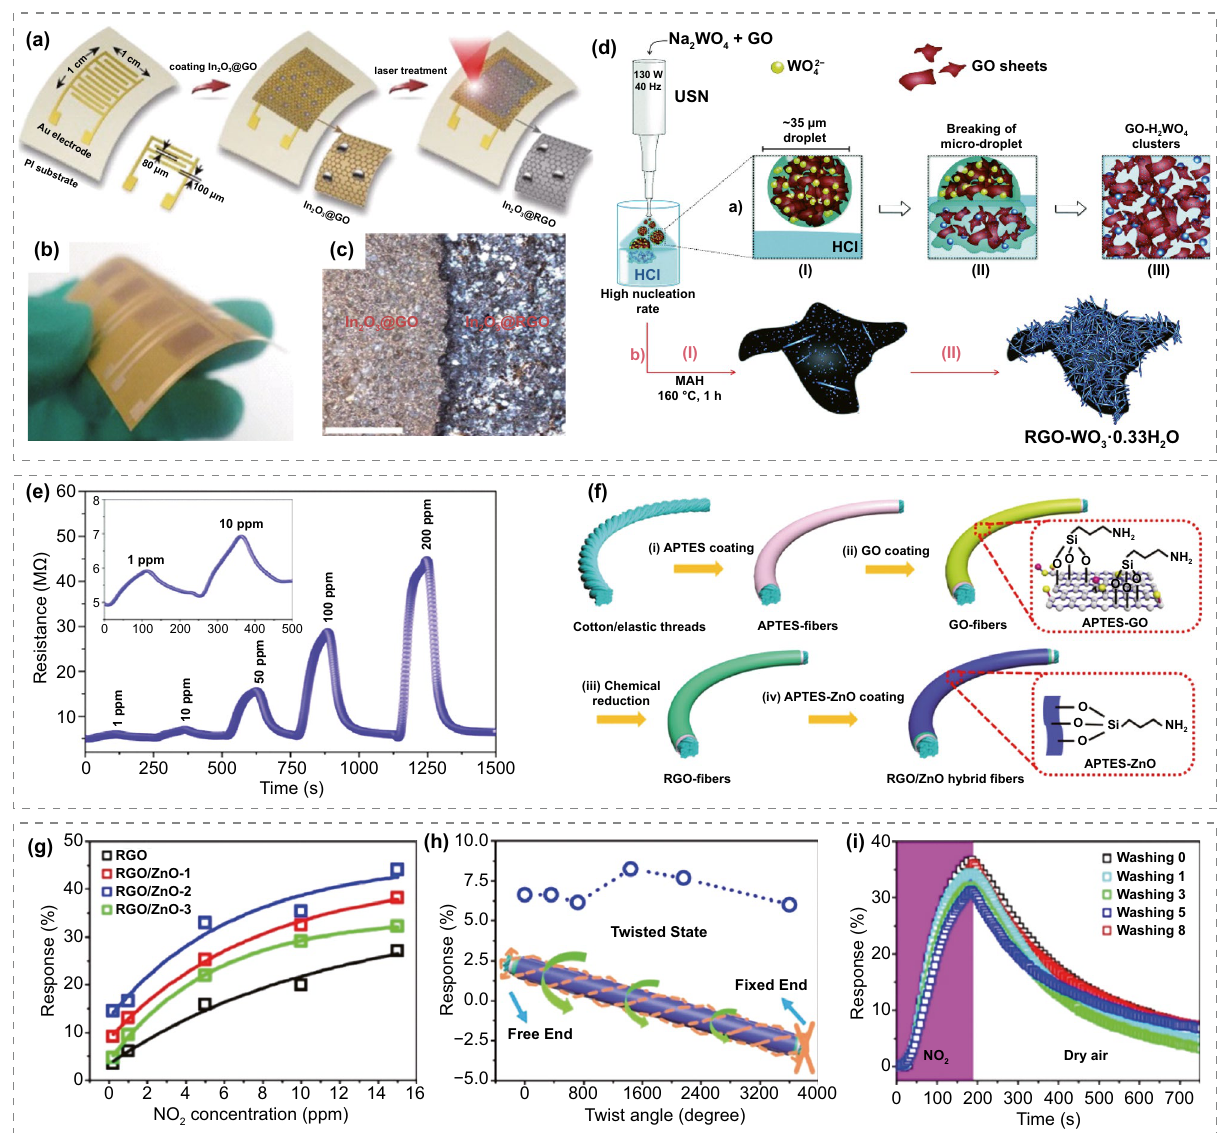
Fig. 7 a Schematic illustration of the fabrication process for In 2 O 3 @RGO sensors. b The optical image of the 2 × 4 In 2 O 3 @RGO sensor array. c The confocal laser scanning microscopy images of the border of GO and RGO. Reproduced with permission from Ref. [65]. Copyright (2018) Elsevier. d Schematic illustration of the fabrication process for RGO/WO 3 ·0.33H 2 O hybrids. e Transient resistance of the RGO/WO 3 ·0.33H 2 O hybrids. Reproduced with permission from Ref. [108]. Copyright (2018) The Royal Society of Chemistry. f The process flow for preparation of RGO/ZnO hybrid threads. g Transient response of RGO and RGO/ZnO to different NO 2 concentration. h Response of RGO/ZnO sensors under different twist angles in 2 ppm NO 2 (0°, 360°, 720°, 1440°, 2160°, and 3,600°). i Response versus time plot of the RGO/ZnO sensors under dif‑ ferent washing times. Reproduced with permission from Ref. [54]. Copyright (2019) American Chemical